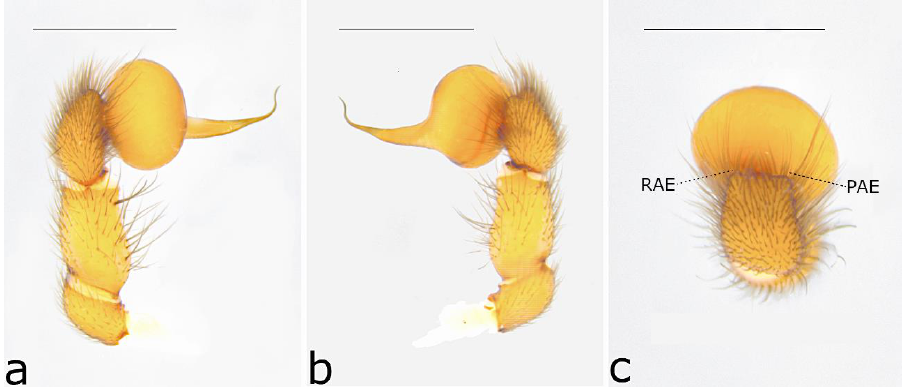
Figure 47. Ariadna propria sp. nov. ♂ holotype (SAMA NN30560) from Melrose (SA): ( a ) left pedi- palp, prolateral view; ( b ) same, retrolateral view; ( c ) same, cymbium. Scale bar = ( a , b ) 1 mm and ( c ) = 0.5